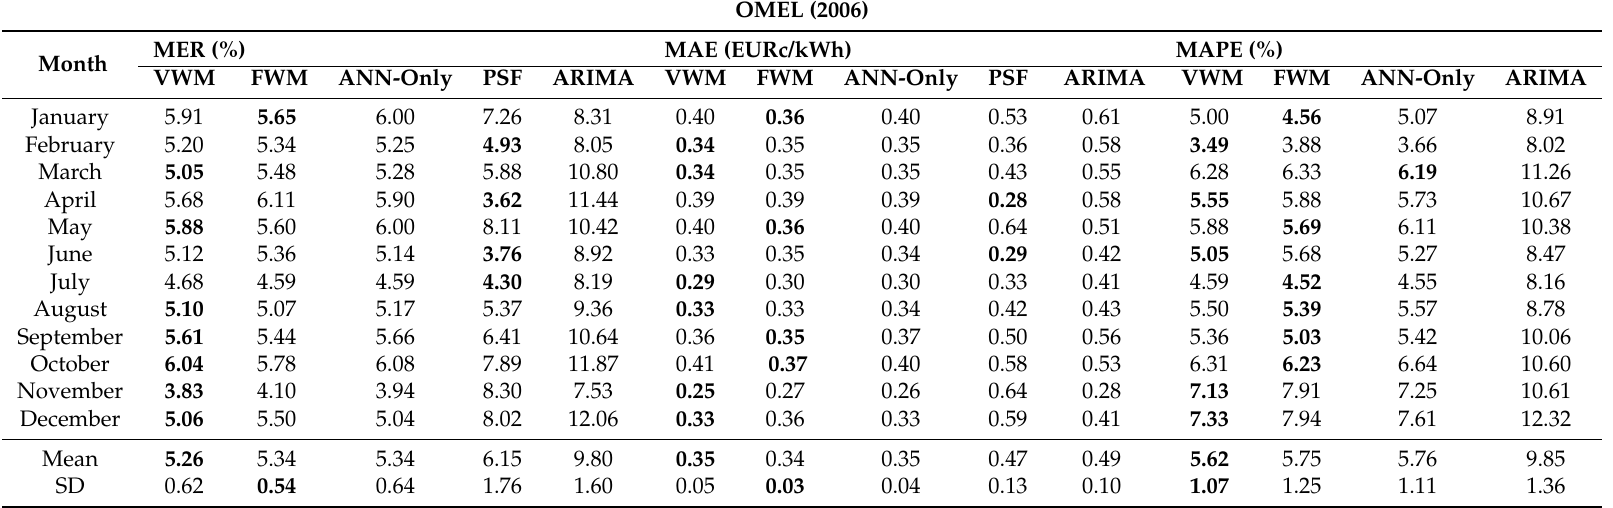
Table 4. MER, MAE and MAPE evaluation metrics for the Spanish OMEL (Operador del Mercado Ibérico de Energía, Polo Español, S.A.) market for the year 2006 (Experiment